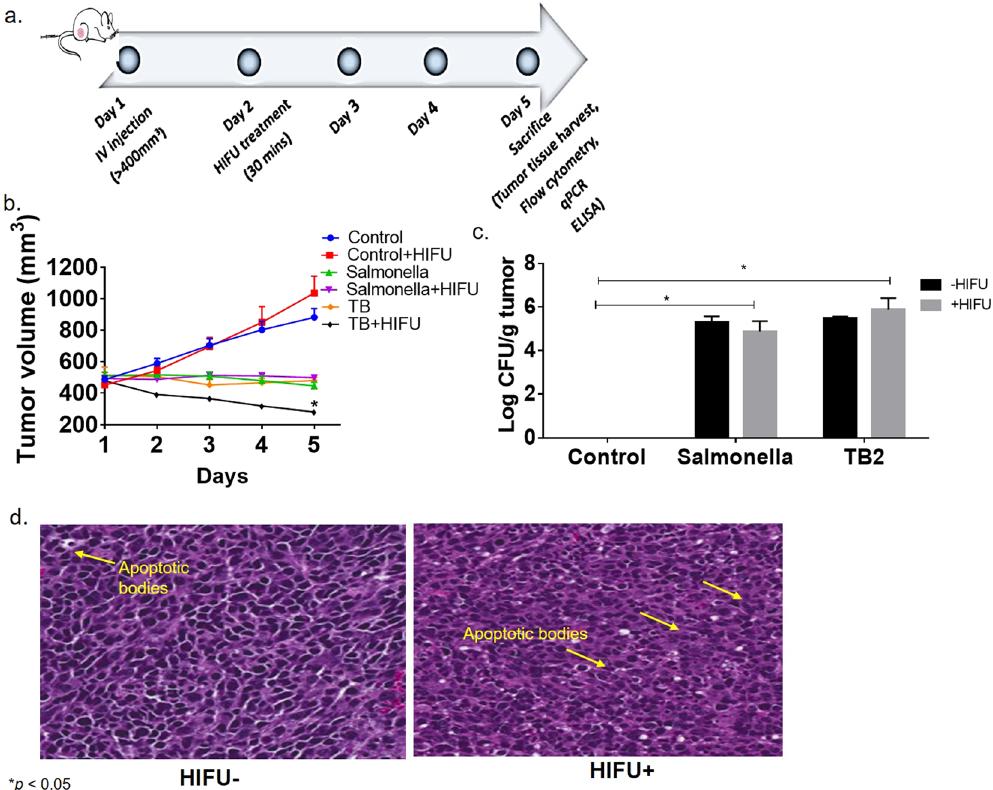
Figure 4. In vivo efficacy in C26 colon tumor model following HIFU/TB treatment. ( a ) Female Balb/c mice (n = 6/group) were inoculated with 0.5 million C26 cells subcutaneously in the flank region. Mice were treated at a volume of > 400 mm 3 mice with a single dose of saline/Salmonella/TB (IV). 24 h post bacterial injection, HIFU treatment was administered for 30 min. Treated mice were sacrificed on day 5 post HIFU and the organs were processed for immunopathology; ( b ) Significant tumor regression with TB/HIFU compared to all other groups was noted over 5days. ( c ) Colony forming unit (CFU) per gram of tumor enumerated by plating tumor homogenates on LB agar suggested efficient tumor colonization with TB in the presence and absence of HIFU. ( d ) H & E section of mice tumors suggested an increase in the apoptotic bodies for HIFUed tumors in comparison to untreated tumors. Values represent means ± SE for each treatment; * p < 0.05 from control (ANOVA followed by